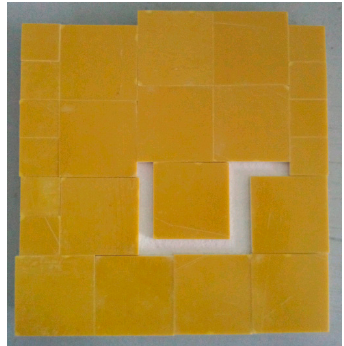
Figure 8. Sample 3 of defect.